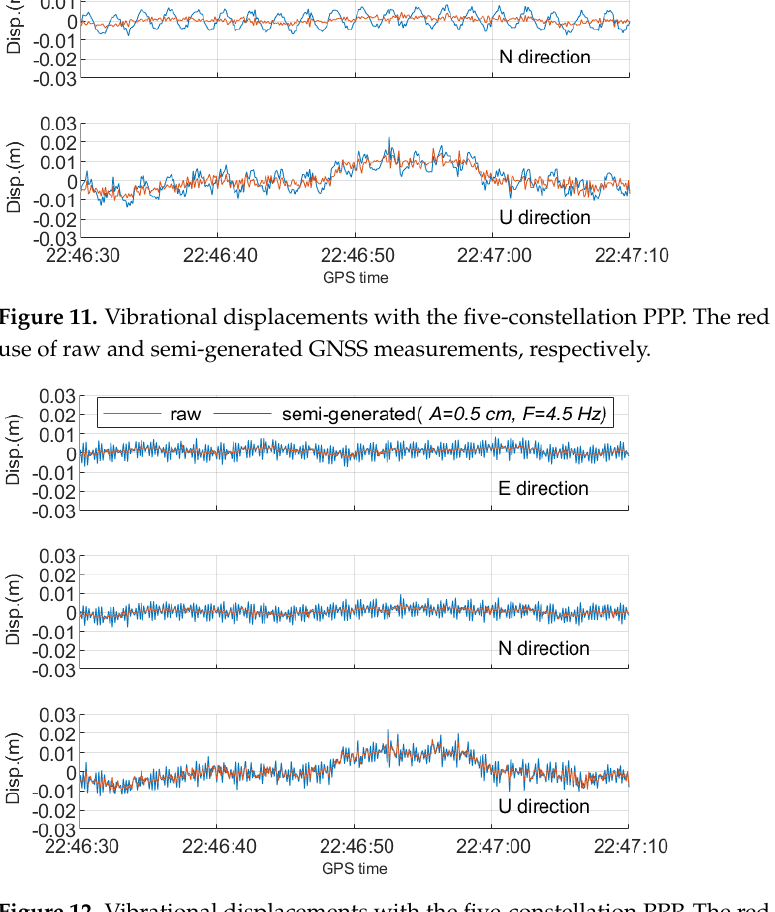
Figure 12. Vibrational displacements with the five-constellation PPP. The red and blue refer to the results of raw and semi-generated GNSS measurements, respectively.